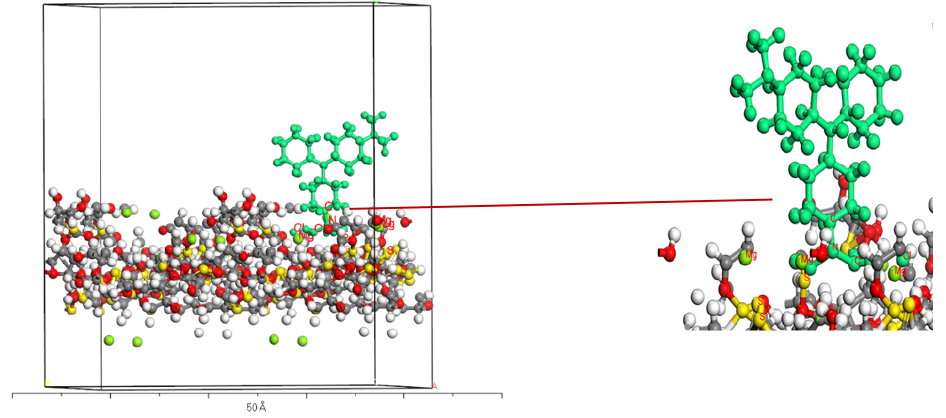
Figure 20. MDG fi ber ( − 1 1 0) surface and single MG molecular adsorption simulation (structure C) configuration.